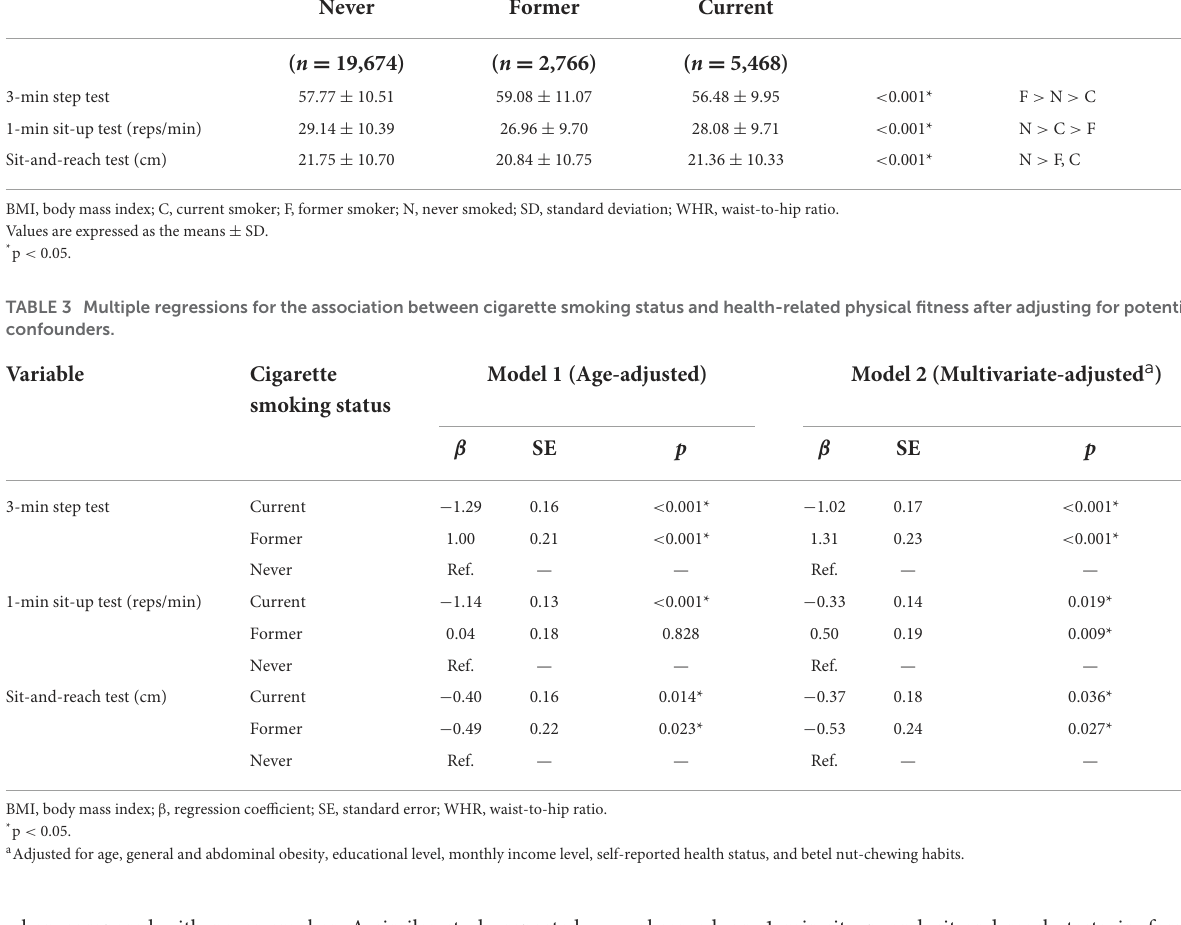
TABLE 2 Health-related physical fitness measurements according to cigarette smoking status among male Taiwanese adults. Variable